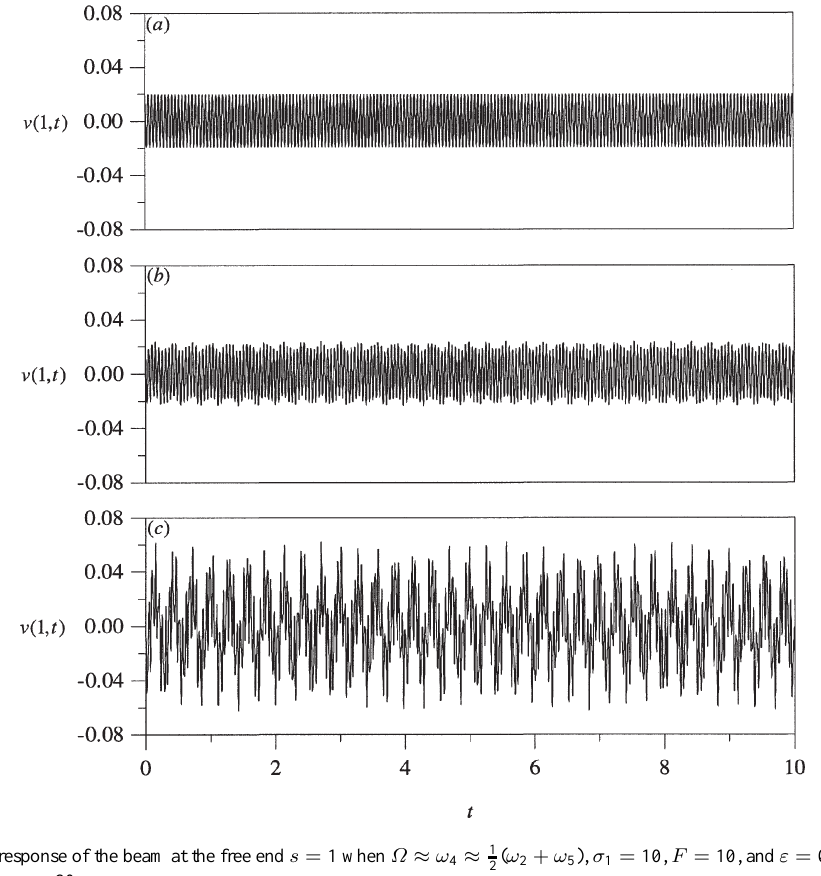
( ! 2 + ! 5 ), (cid:27) 1 = 10, F = 10, and " = 0 : 1. (a) (cid:27) 2 = (cid:0) 10 : 5, 2